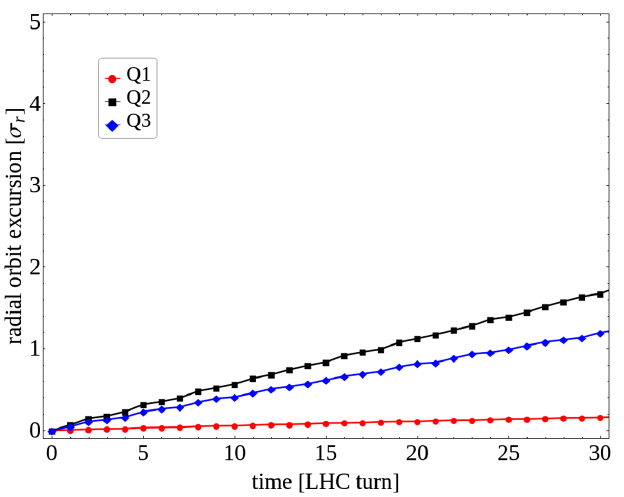
FIG. 13. The orbit excursion induced by a CLIQ discharge using the new baseline in the three types of triplet magnets Q1, Q2 and Q3, using flat optics. For each type, only the magnet with the largest kick is shown. To be compared with the round optics case shown in Fig.